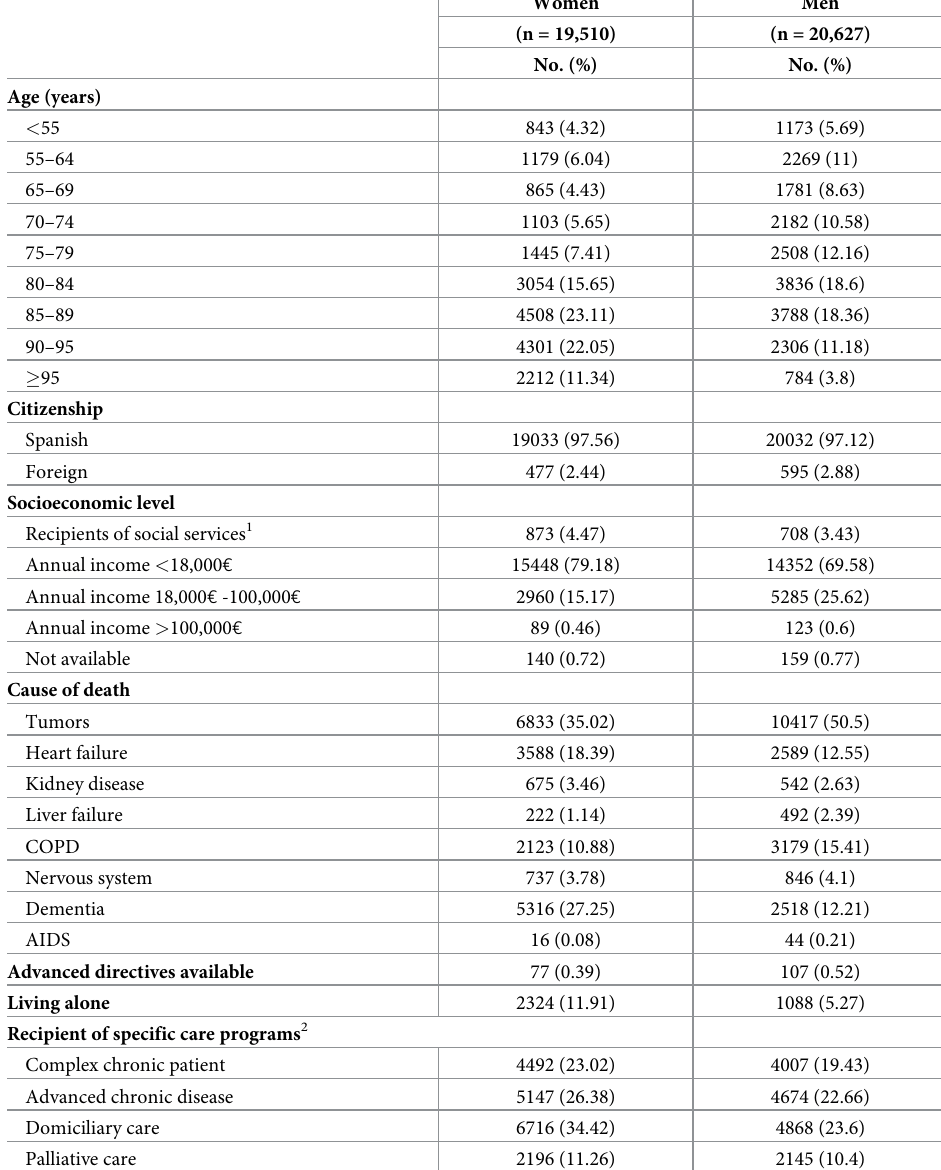
Table 1. Demographic, socioeconomic, and clinical characteristics of the study